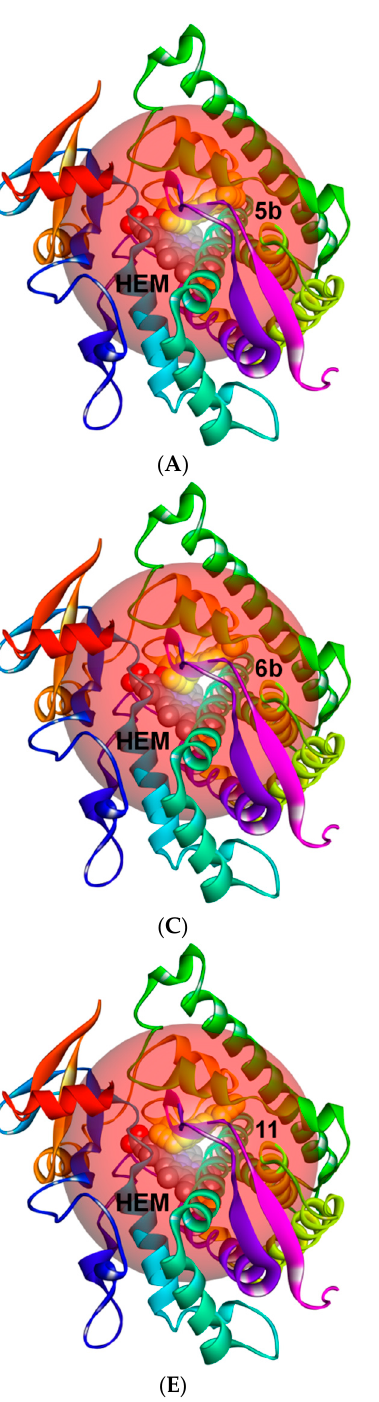
Figure 2. The tertiary structure of human CYP1B1 complexed with compounds 5b ( A ), 6b ( C ), and 11 ( E ) and a closer view of the orientation of compounds 5b ( B ), 6b ( D ), and 11 ( F ) inside the active site, near the heme–iron center. The protein’s backbone and active site are rendered as ribbon and green mesh, respectively.